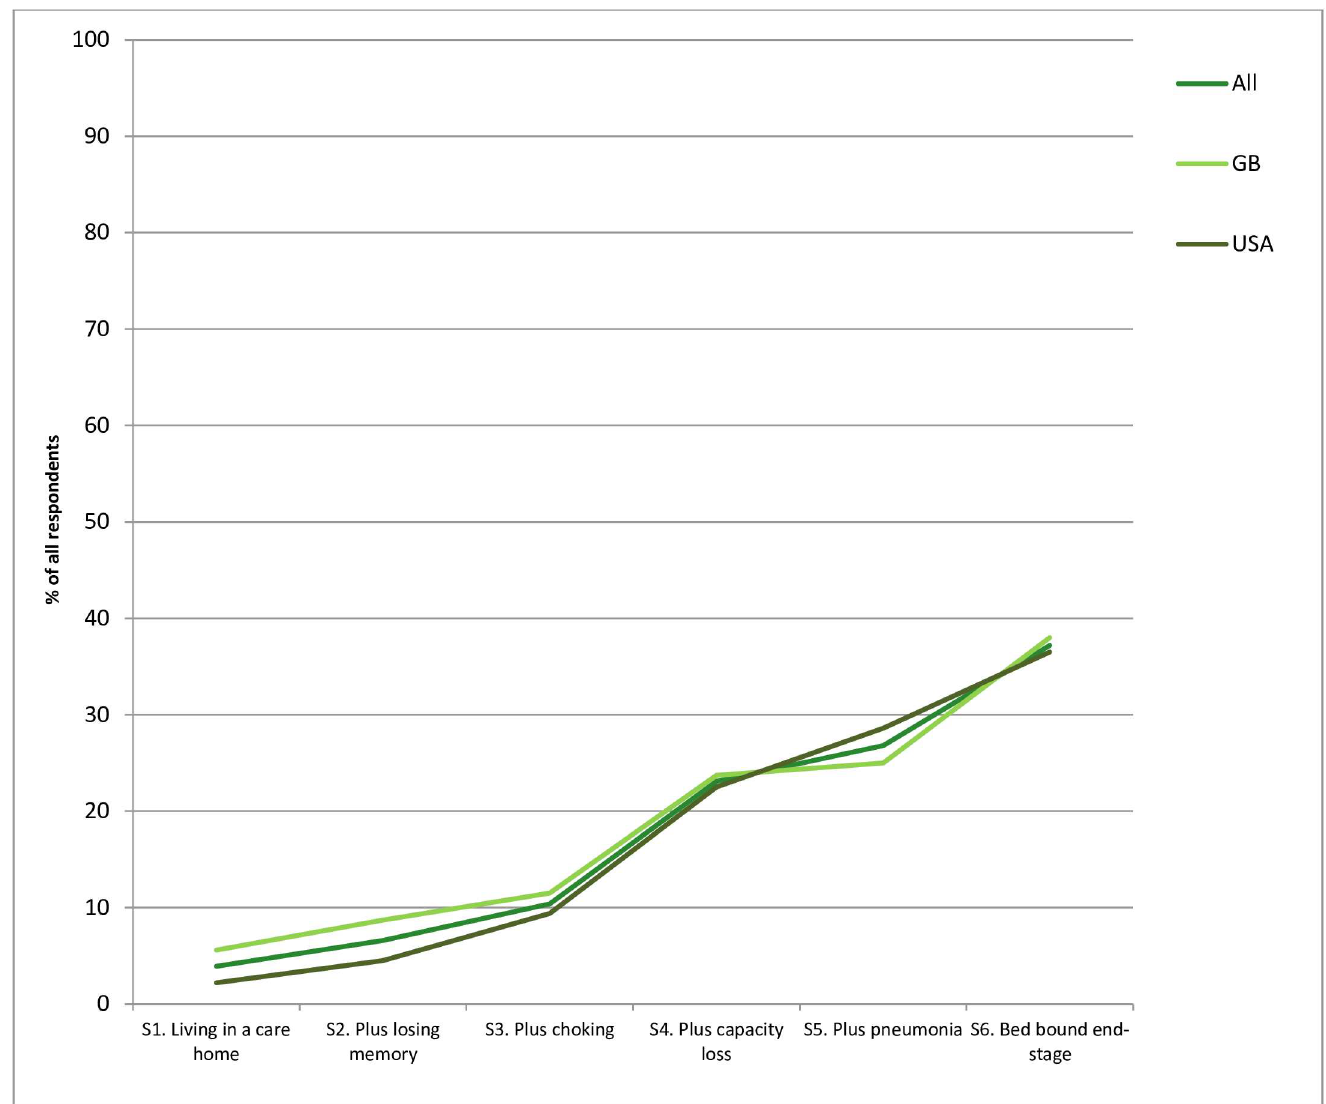
Fig 3. Percentage of respondents choosing “measures to help me die peacefully” across six stages (N = 2016).